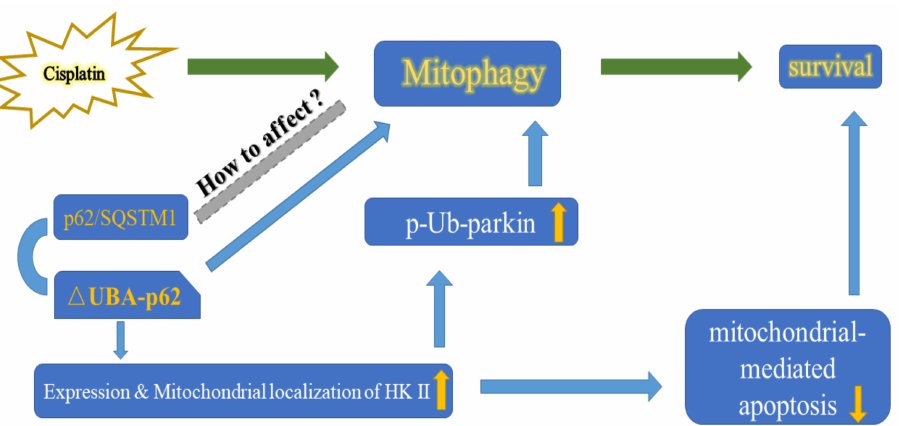
Figure 7. Proposed model by which the UBA domain deletion of p62 promotes the expression & mitochondrial localisition of HK2 then increases p-Ub-parkin during cisplatin induced